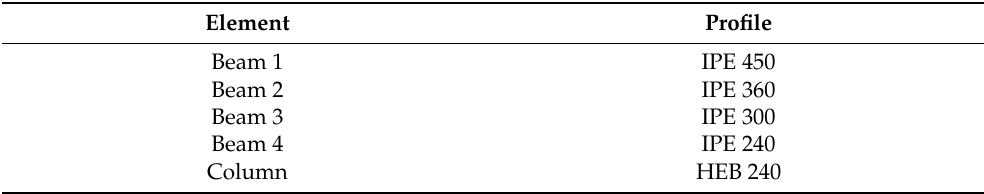
Table 8. Beam and column cross-sections of the multi-storey case studies after vertical static analysis design.